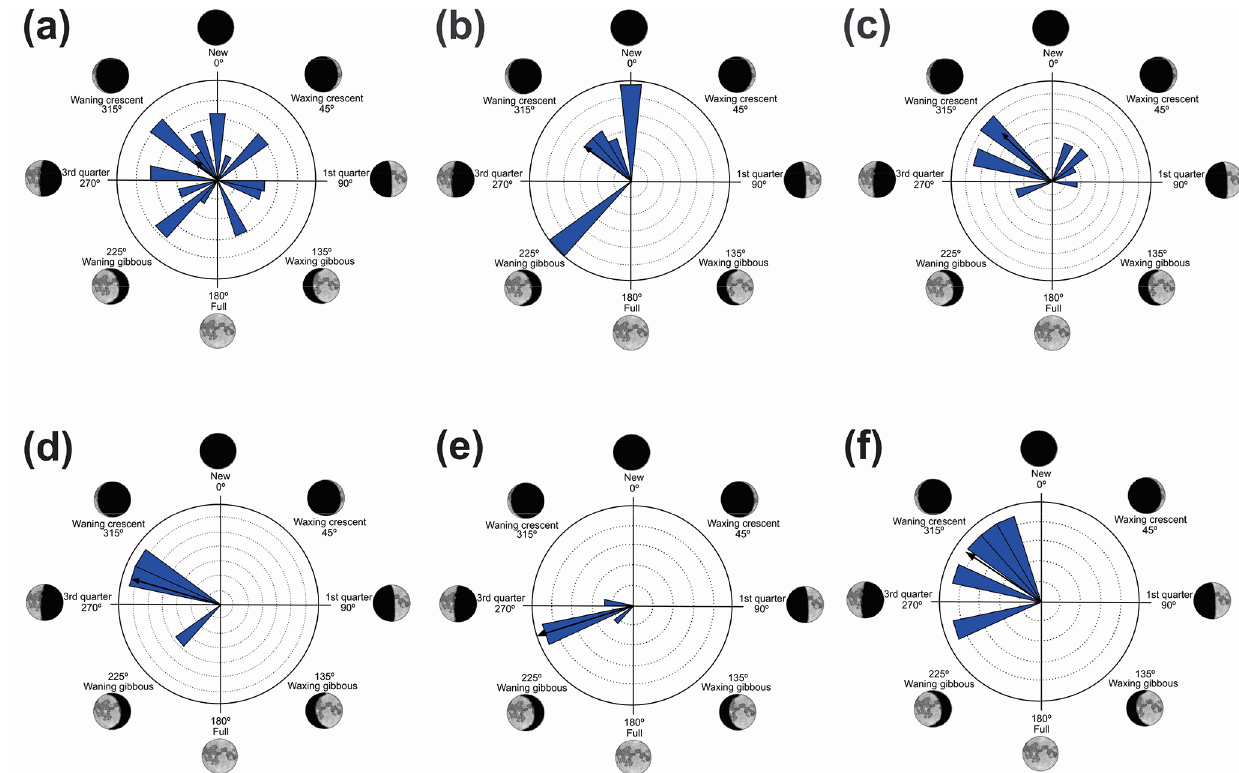
Figure 6. Species with non-random unidirectional behavior in quadrant IV of the polar axis (226–314 ◦ ) clockwise, under the influence of the synodic cycle between the waning gibbous and waning crescent (intermediate albedo): (a) Boana polytaenia , (b) Hylodes phyllodes , (c) Ischnocnema aff. guentheri , (d) Myersiela microps , (e) Ololygon hiemalis , and (f) Proceratophrys boiei